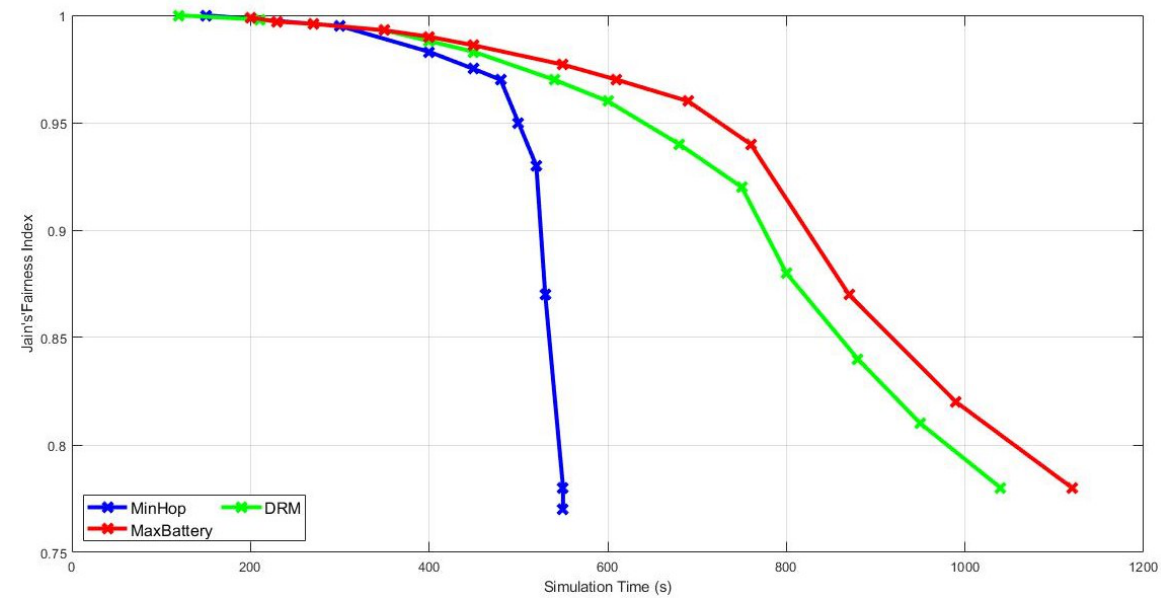
Figure 4. Jain’s Fairness Index for the proposed strategies: MaxBattery, DRM and MinHop.